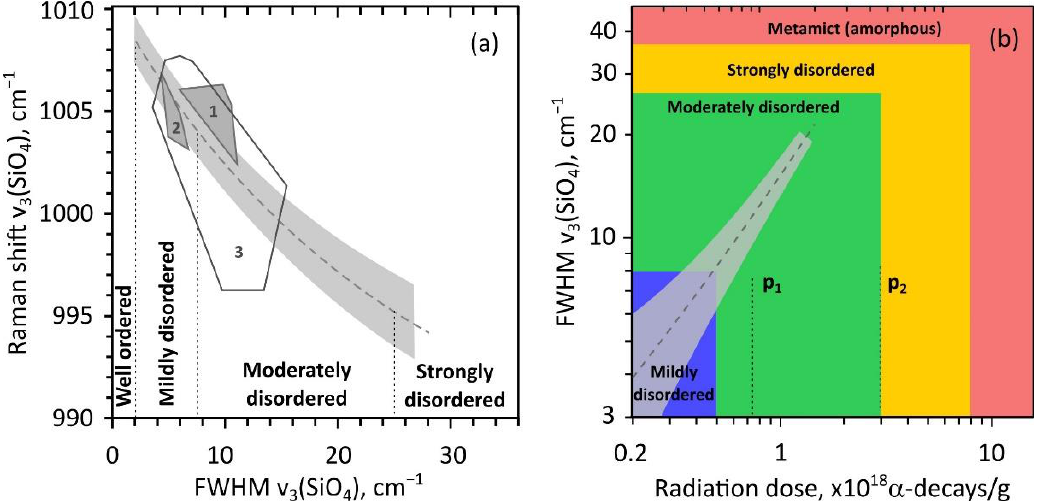
Figure 4. Raman band parameters and radiation doses: ( a ) Raman shift and FWHM (full width at half maximum) of band ν 3 (SiO 4 ) polygons were built using the data of [5] (dark-gray field 1 is Reis, dark-gray field 2 is Popigai, dark-gray solid line 3 is Chicxulub crater, dotted line is boundaries between levels of structure disorder); ( b ) Plot of FWHM ν 3 (SiO 4 ) against the equivalent radiation dose D α ed ; the positions of percolation points p 1 , p 2 [68,69] and the boundaries between levels of structure disorder (colors) are debatable and shown approximately. The light gray fields with broken lines (in ( a , b )) are regions of calibrated values on natural unaltered and unstressed samples, according to [9].